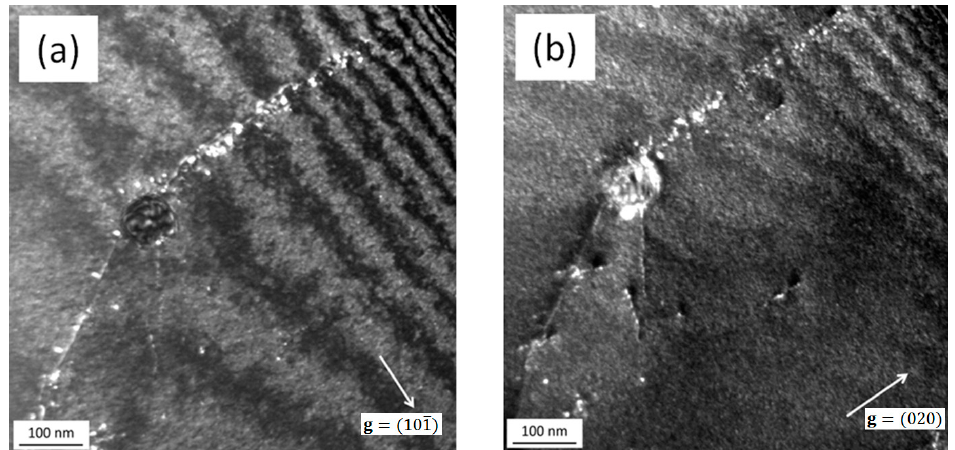
Figure 3. TEM weak-beam dark-field images of a dislocation decorated with loops for the Fe-12Cr alloy that was irradiated to 0.6 dpa. ( a ) Di ff raction vector g = ( 101 ) ; ( b ) same detail, g = ( 020 ) .